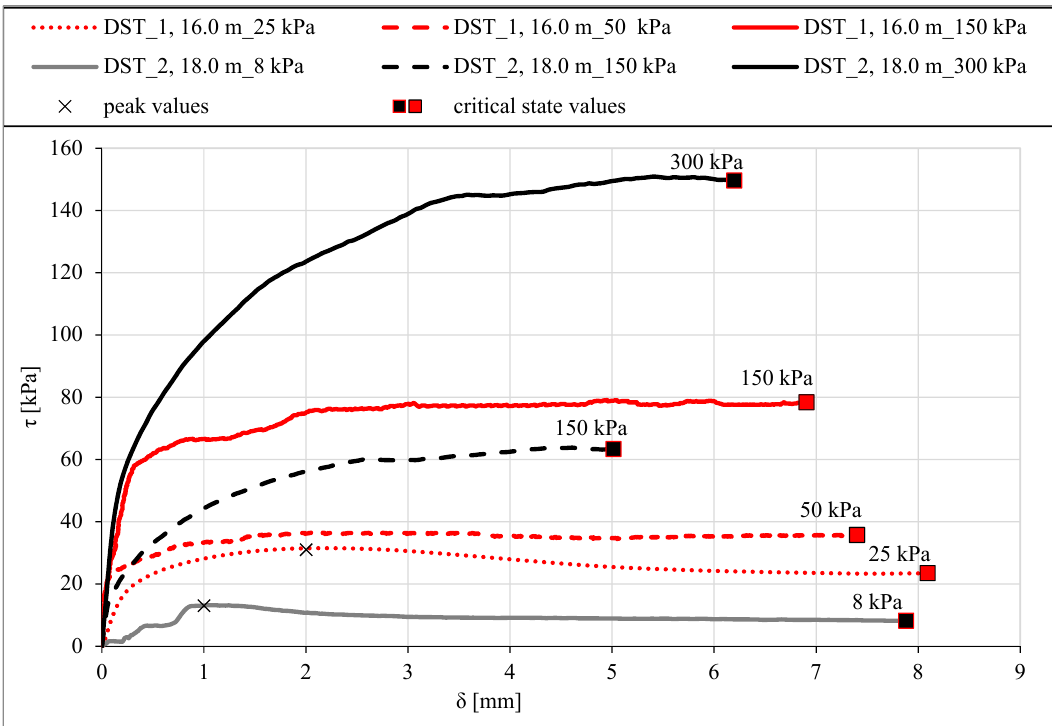
Figure 10. Direct shear test results of Sub-Apennine clay (ASP) samples: shear stress, τ , versus horizontal displacement, δ .